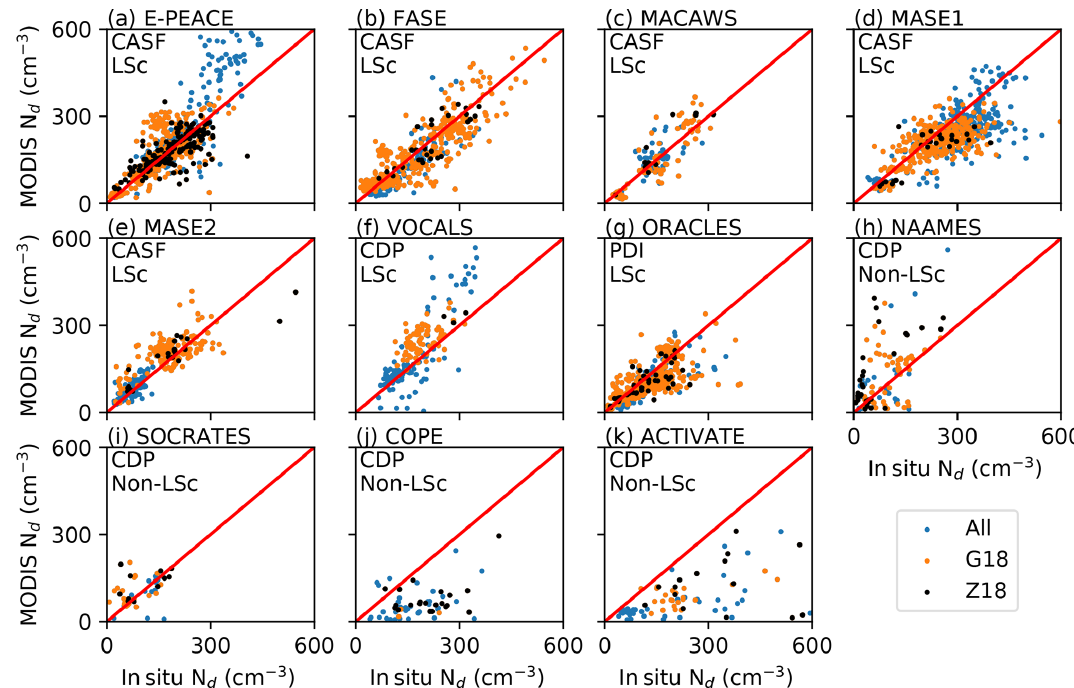
Figure 3. Comparison between MODIS and in situ N d at a pixel level, for aircraft data within 15min of a MODIS (Aqua or Terra) overpass. Blue is data that do not satisfy G18; orange dots are G18 sampling; and green are Z18. The instrument used in each campaign and the main cloud type (LSc – liquid stratocumulus) is shown in the top left of each subplot.